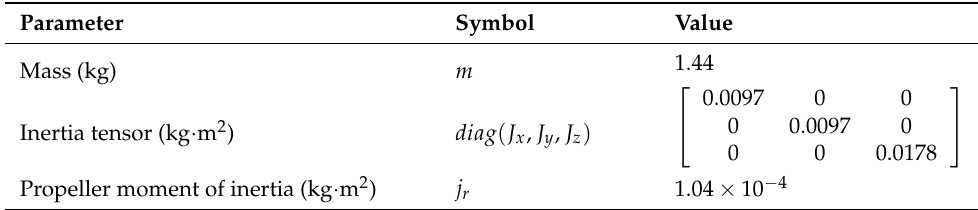
Table 1. QUAV nominal model